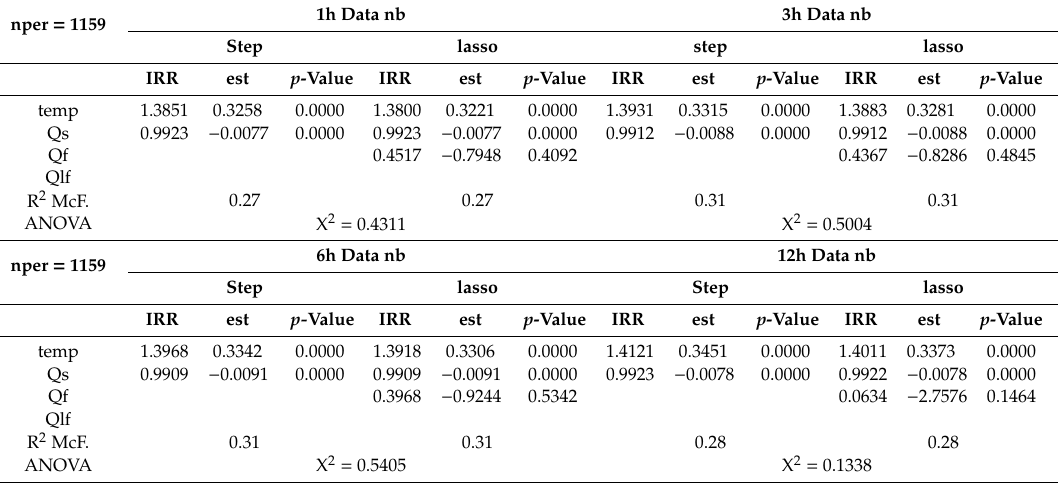
Table 9. Results of variable selection of Percidae (nper).